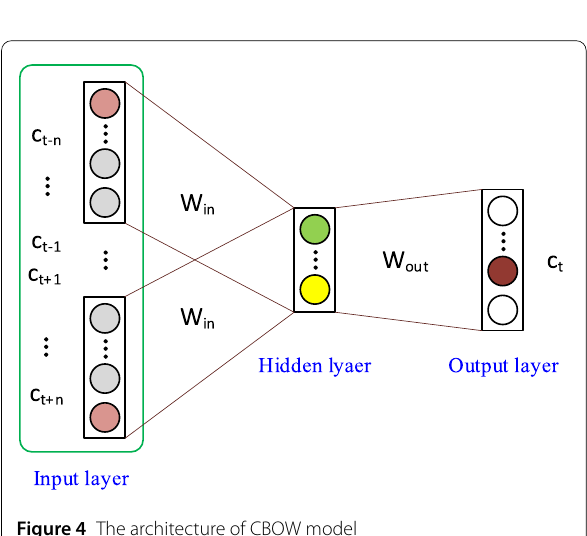
Figure 4 The architecture of CBOW